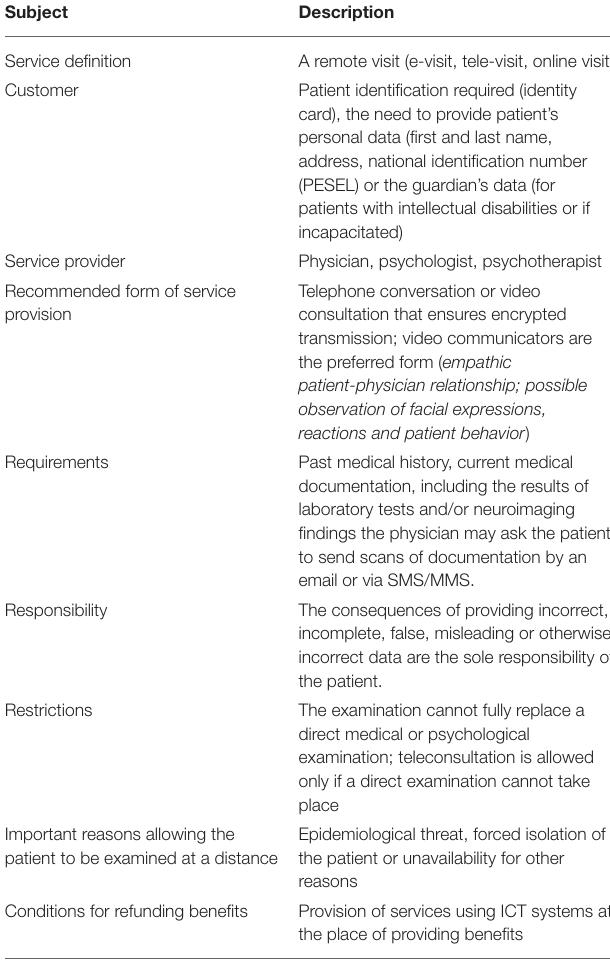
TABLE 1 | Characteristic of telepsychiatric services available in